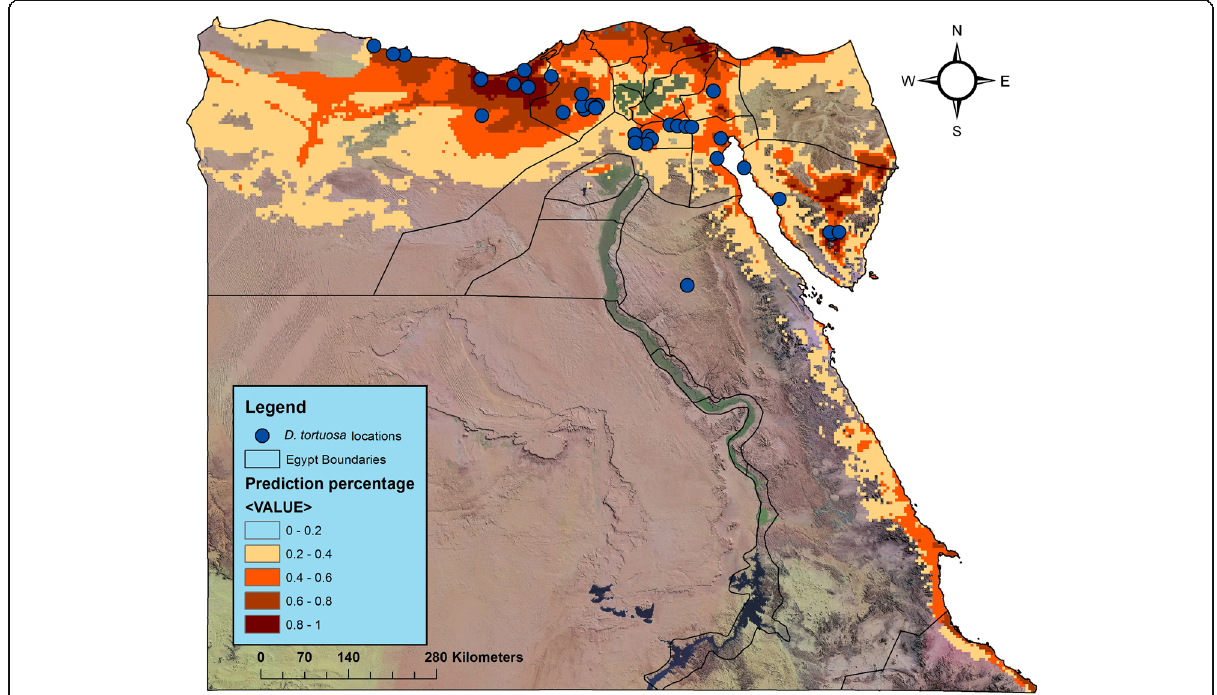
Fig. 8 Training data (AUC = 0.994) and test data (AUC = 0.999) compared to random prediction (AUC = 0.5) in the receiver operating characteristic (ROC) curve for the representation of the MaxEnt model for S. buboniae